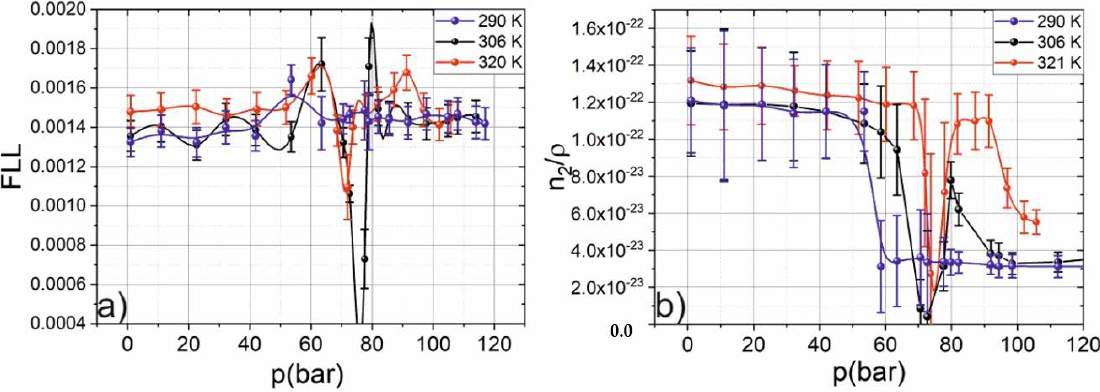
Figure 3. The dependence of the Lorentz–Lorentz function (FLL) ( a ) and normalized nonlinear refractive index ( b ) on pressure at different temperatures.